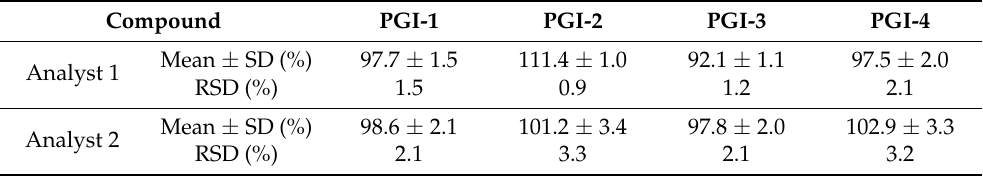
Table 3. Repeatability and intermediate precision for the developed UPLC-MS/MS method ( n =